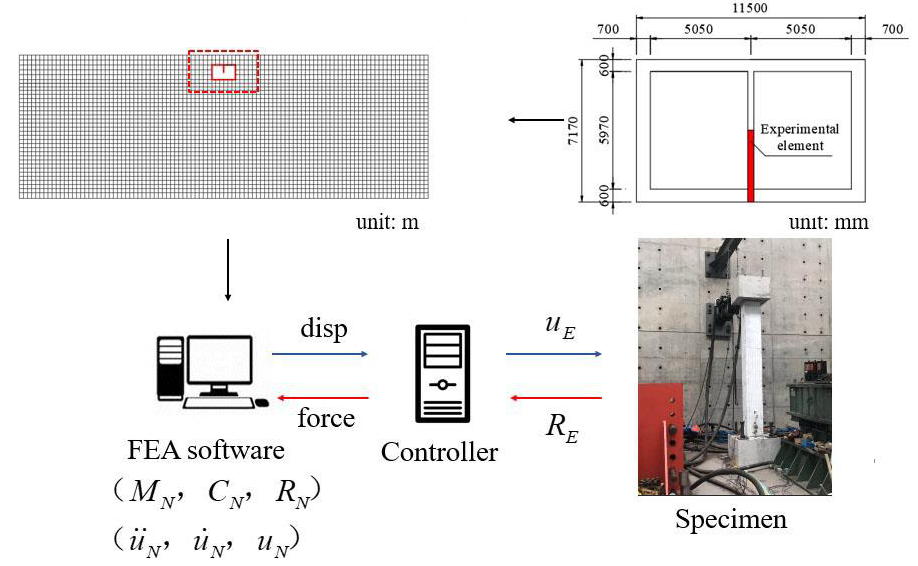
Figure 4. Key components of the hybrid simulation model.